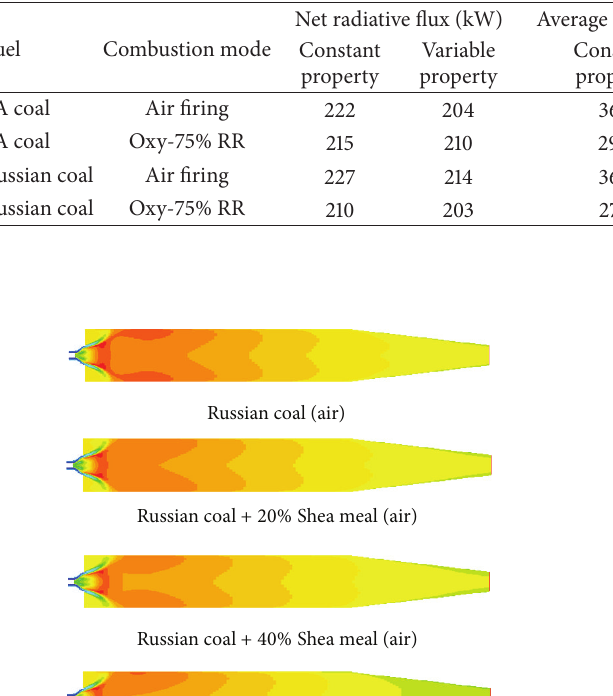
Table 3: Radiation and temperature predictions during coal combustion.